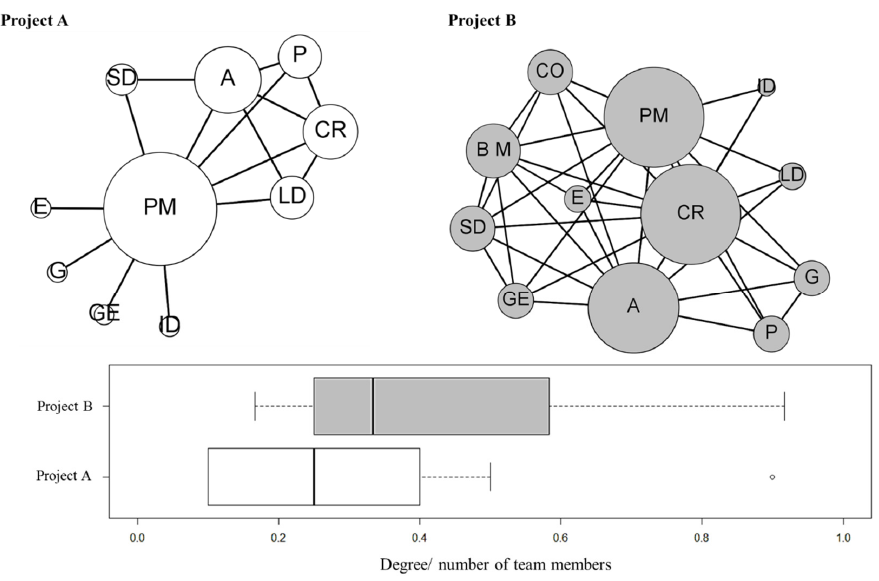
Figure 3. Global interaction network and degree: Project A and project B.